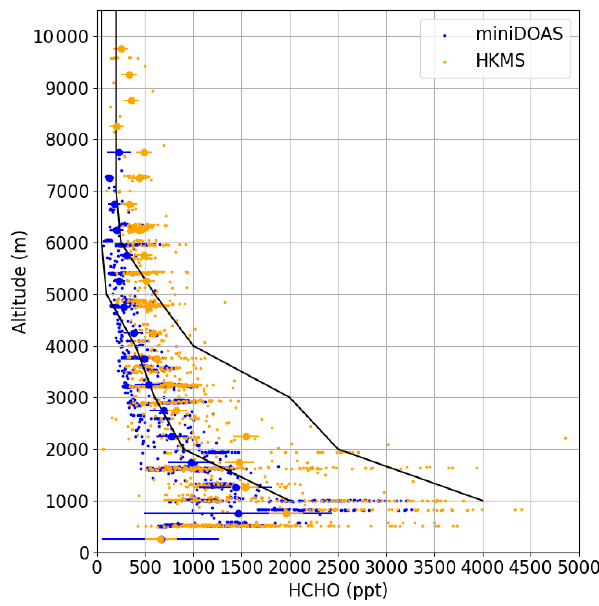
Figure 16. HCHO measurements by the HKMS (in orange) and the miniDOAS instruments (in blue). Mean values (bigger dots) and the respective accuracies (horizontal bars) are also shown. The black lines indicate the range of previous HCHO measurements over North America in summer (Kluge et al., 2020). Note that HKMS and miniDOAS agree within their accuracies in spite of having dif- ferent air sampling volumes, which did not perfectly